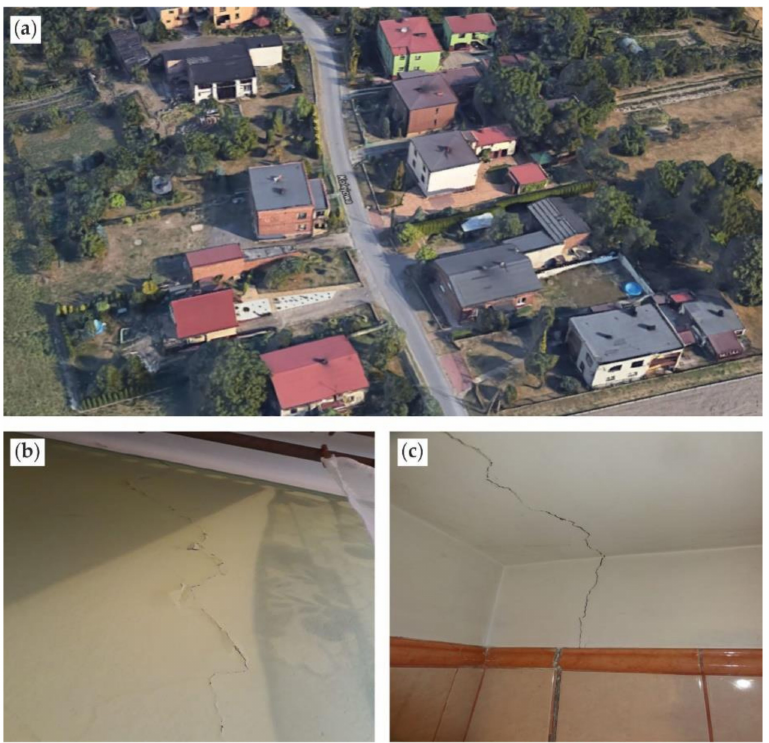
Figure 8. ( a ) The characteristic buildings of smaller towns and villages in Upper Silesia in the research area (google.pl/maps); ( b , c ) the characteristic damages that occurred in single-family residential buildings (own